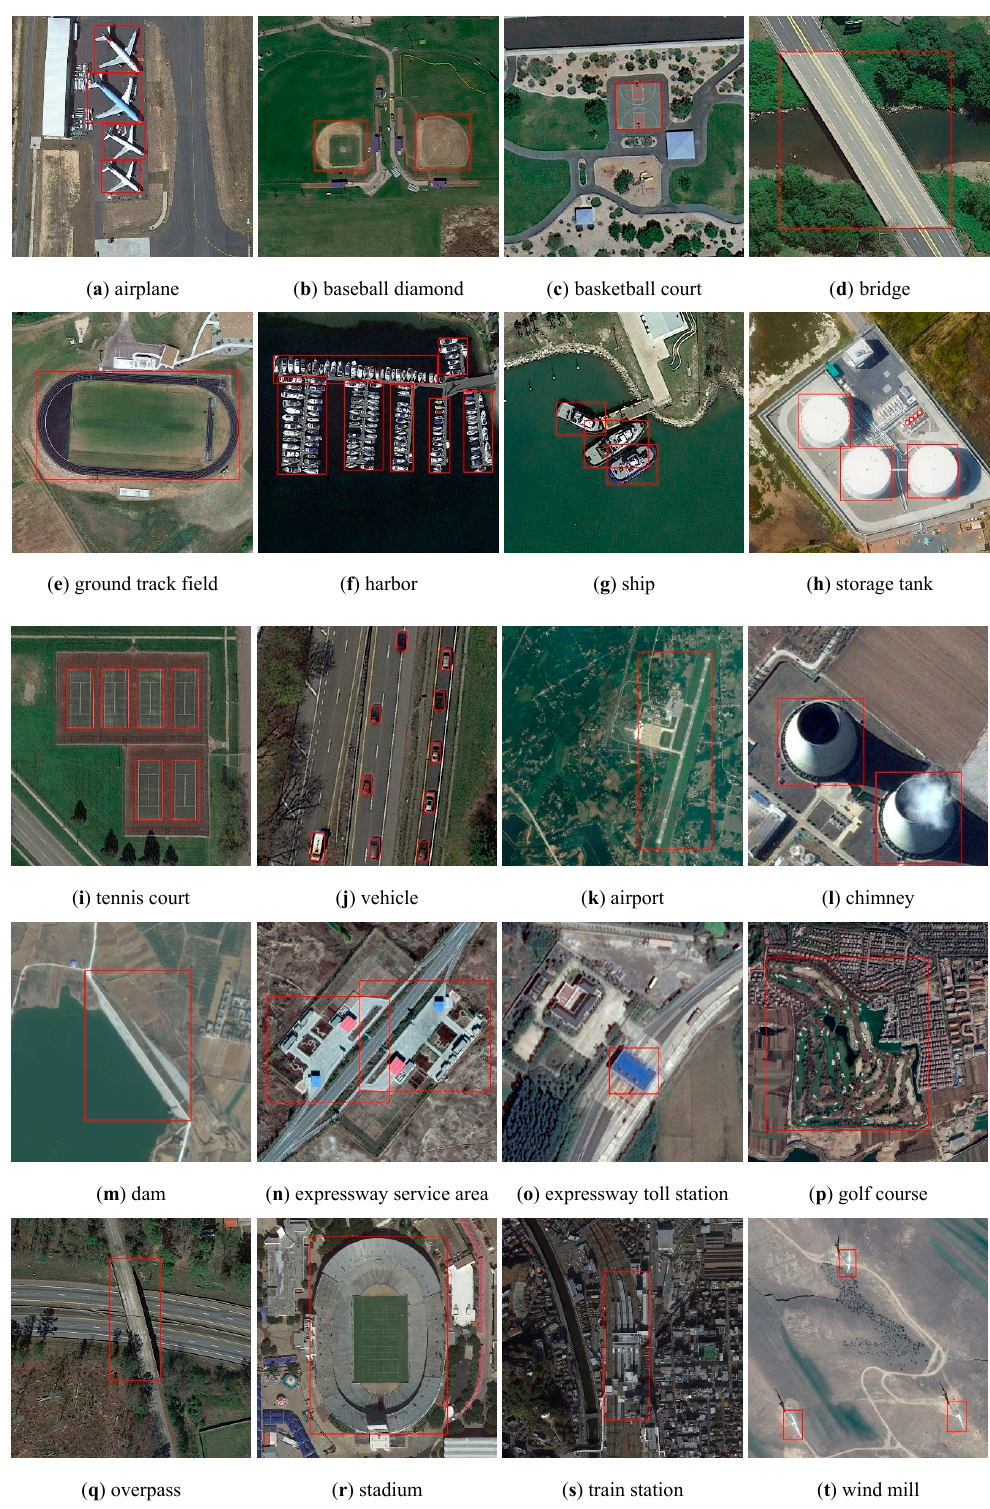
Figure 5. Examples of images from the NWPU VHR-10 and DIOR benchmark dataset, where ( a ) – ( j ) denotes the categories from the NWPU VHR-10 dataset, and ( a ) – ( t ) represents the categories from the DIOR dataset.